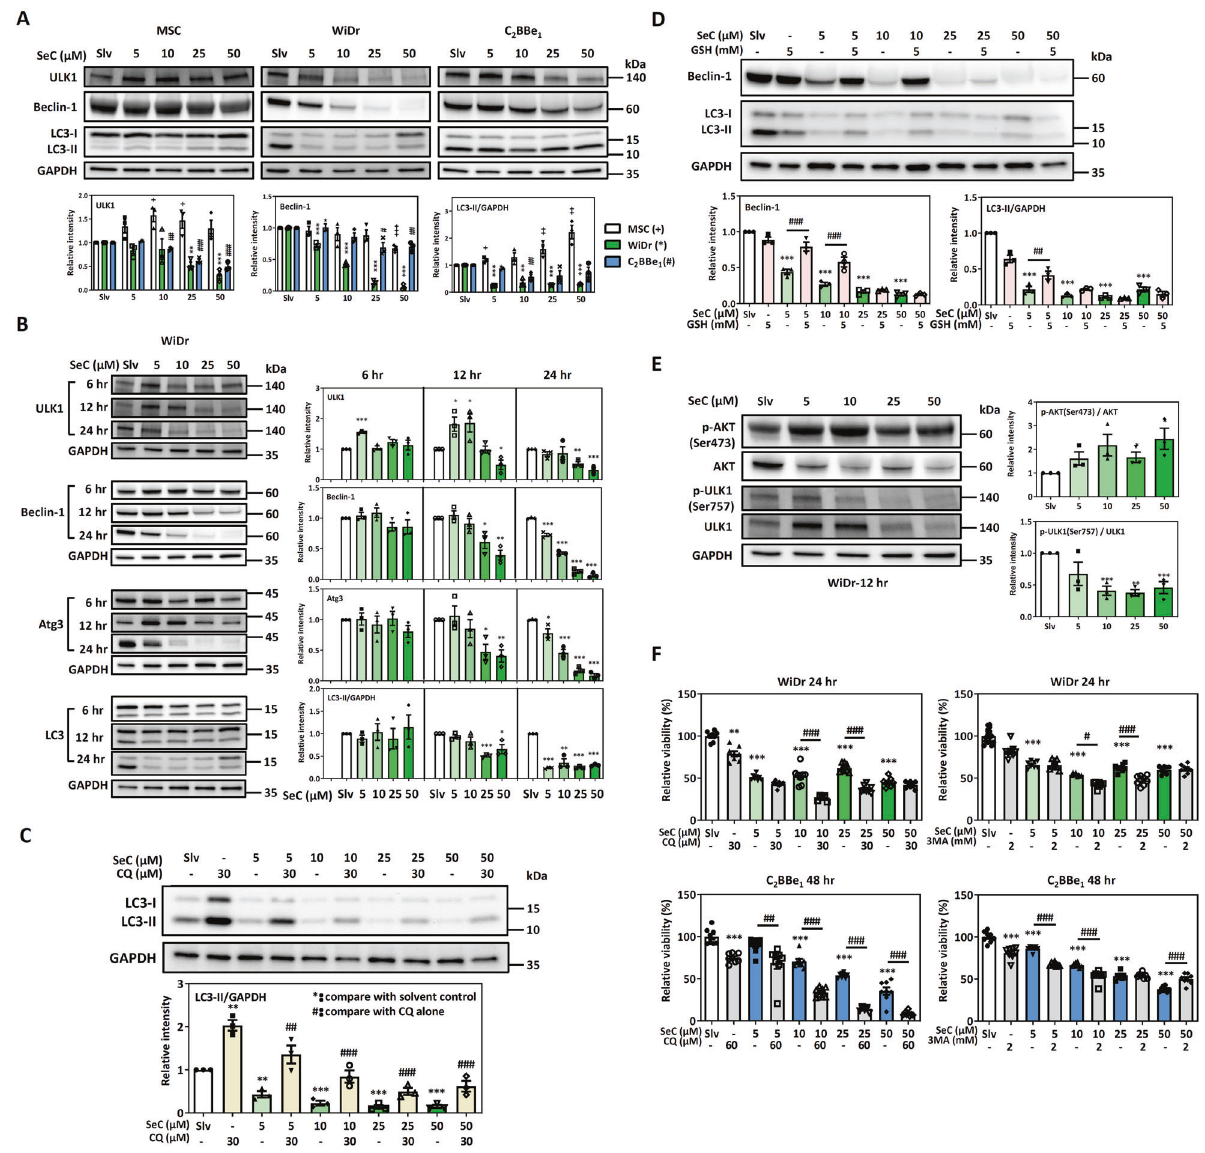
, ***, ### P < 0.001, compared with solvent control for each cell type, Signi fi cance was determined by an unpaired t test). B Autophagy proteins in SeC-treated WiDr cells after 6, 12, and 24 h The values were presented as average ± SD from three independent repeats. (* P < 0.05, ** P < 0.01, *** P < 0.001, compared with solvent control, Signi fi cance was determined by an unpaired t test.). C LC3II were measured in the presence of CQ to determine autophagy fl ux in SeC-treated WiDr cells after 24 h. The values were presented as average ± SD from three independent repeats. (** P < 0.01, *** P < 0.001, compared with solvent control; ## P < 0.01, ### P < 0.001, compared with CQ alone). D Effects of GSH on the autophagy pathway in WiDr cells after SeC treatment for 24 h. Protein levels of Beclin-1 and LC3II were measured by immunoblotting. The values were presented as average ± SD from three independent repeats. (*** P < 0.001, compared with solvent control; ## P < 0.01, ### P < 0.001, compared with SeC treatment without GSH pretreatment, signi fi cance was determined by one-way ANOVA). E AKT and ULK1 phosphorylation in SeC-treated WiDr cells after 12 h. GAPDH was used as loading control ( n = 3). The values were presented as average ± SD from three independent repeats. F Cell viability of WiDr cells and C 2 BBe 1 cells after SeC treatment with or without CQ or 3-MA pretreatment ( n = 8). The values were presented as average ± SD from eight independent repeats. (** P < 0.01, *** P < 0.001, compared with solvent control; ## P < 0.01, ### P < 0.001, compared with SeC treatment without CQ pretreatment, signi fi cance was determined by one-way